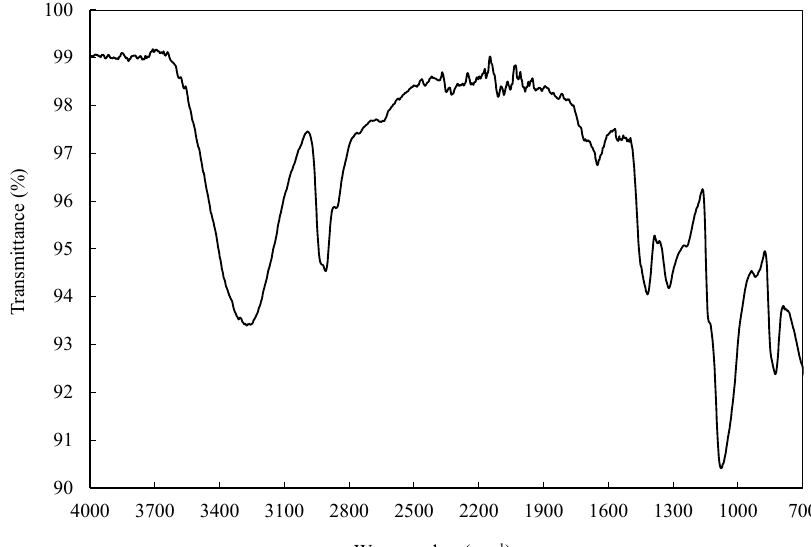
Figure 7. ATR-FTIR spectrum of PVA 1Y.